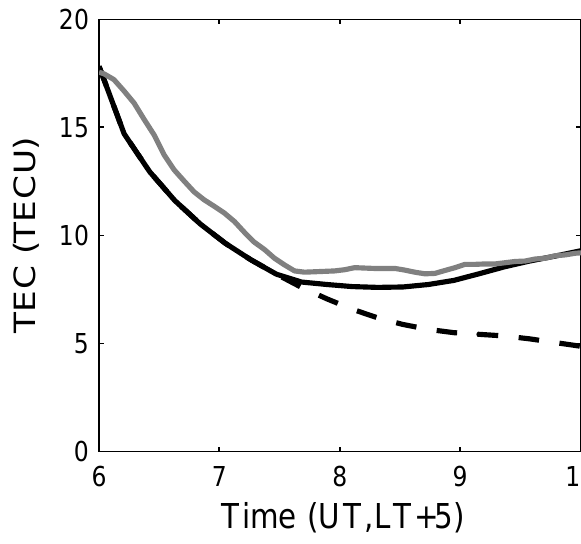
Fig. 11. Contour plot of modeled densities including a horizontal plasma flux term as described in the text. The scale is the same as in Fig. 10.